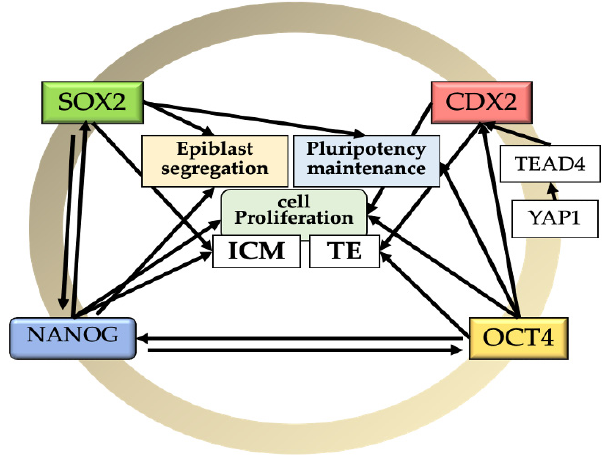
Figure 1. Relationships among the core of pluripotency factors and epiblast segregation, pluripotency maintenance, and cell proliferation during early bovine development. SOX2 : SRY (sex determining region Y)-box 2; OCT4 : octamer-binding transcription factor 4 (POU5F1); NANOG : homeobox protein NANOG ; TE: trophectoderm; ICM: inner cell mass; TEAD4 : TEA Domain Transcription Factor 4; YAP1: Yes Associated Protein 1. Black arrows indicate positive